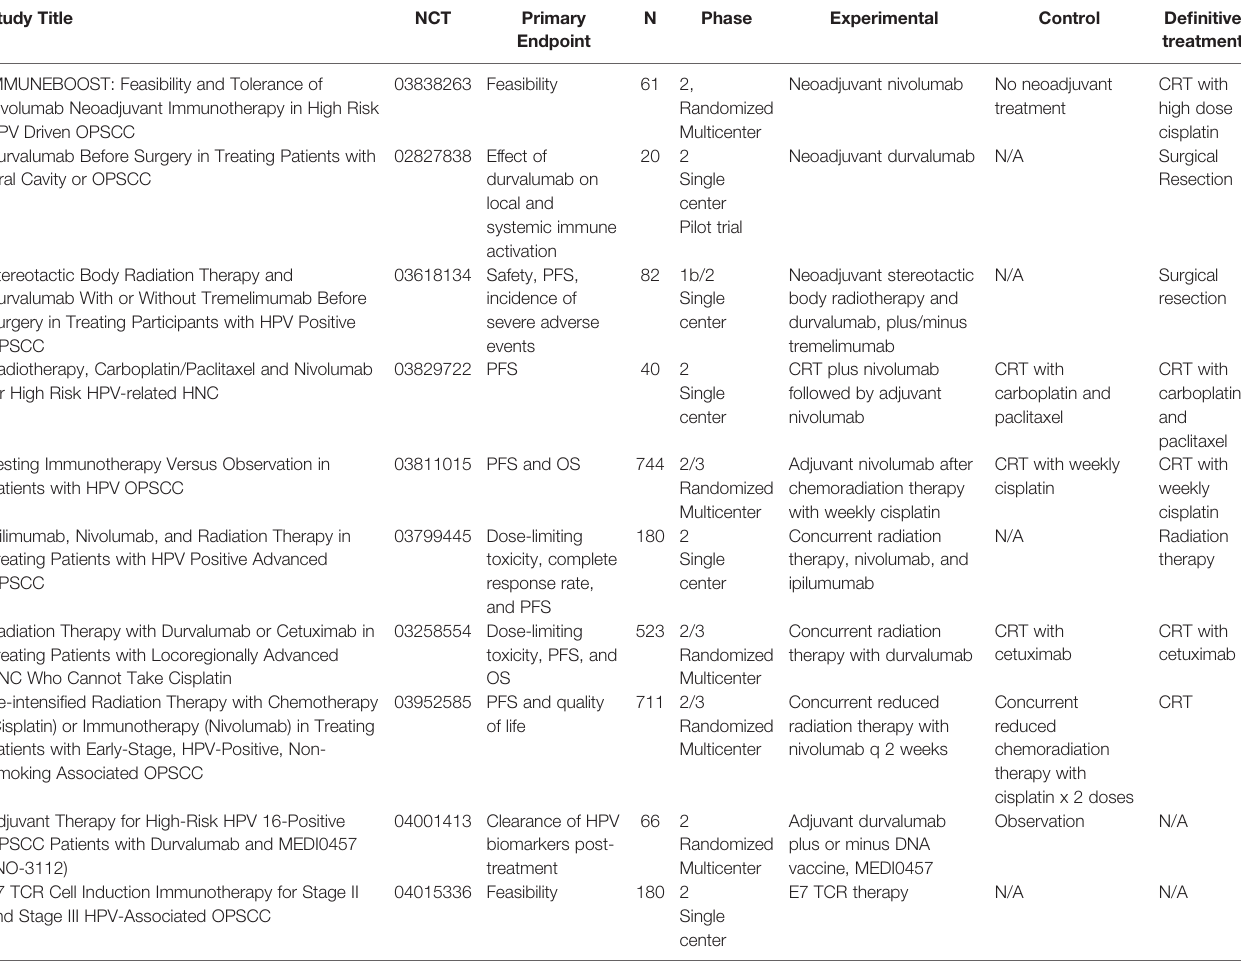
TABLE 1 | Ongoing clinical trials investigating novel immunotherapy drugs or combinations in locally advanced HNC and HPV-positive